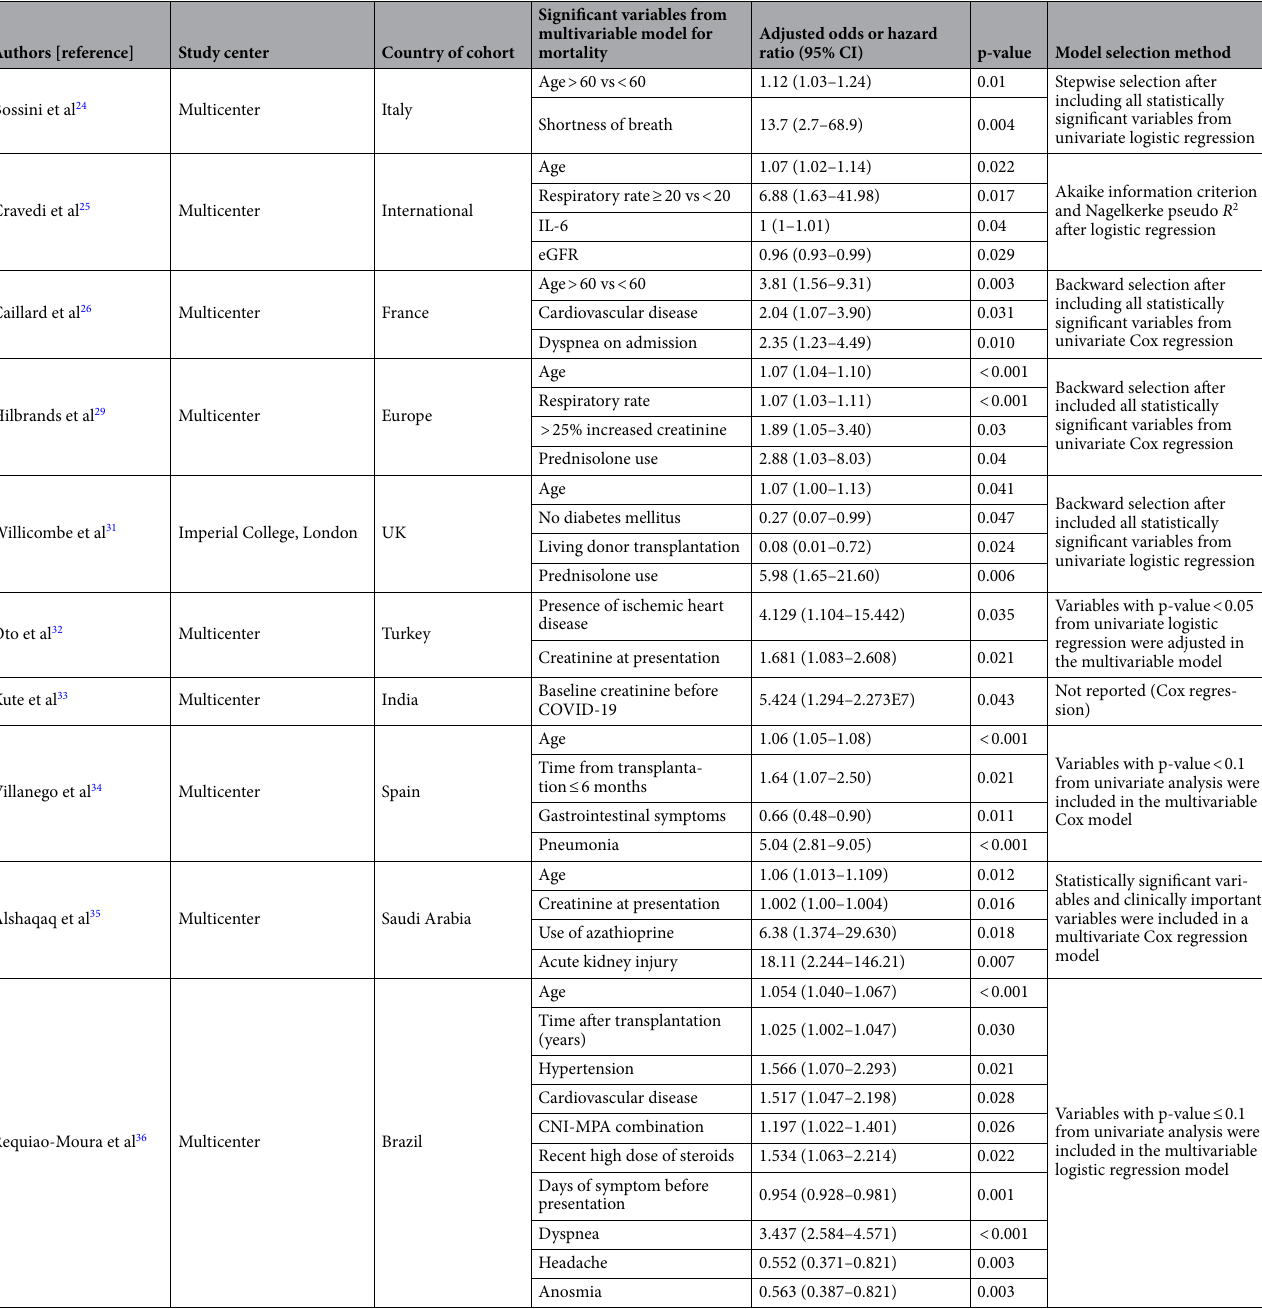
Table 5. Multivariable model for mortality in each study. ARDS acute respiratory distress syndrome, CNI calcineurin inhibitor, eGFR estimated glomerular filtration rate, IL-6 interleukine-6, LDH lactate dehydrogenase, MPA